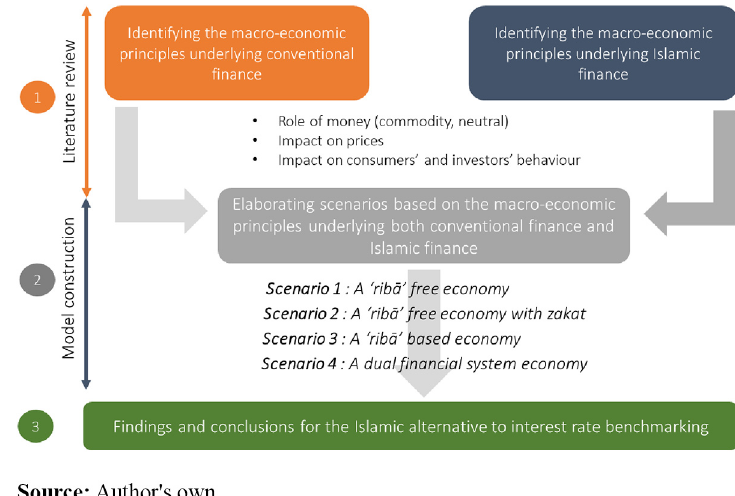
The research model consists of a virtual economy that is composed of three markets of essential goods and services, four pro fi les of economic actors and four scenarios.